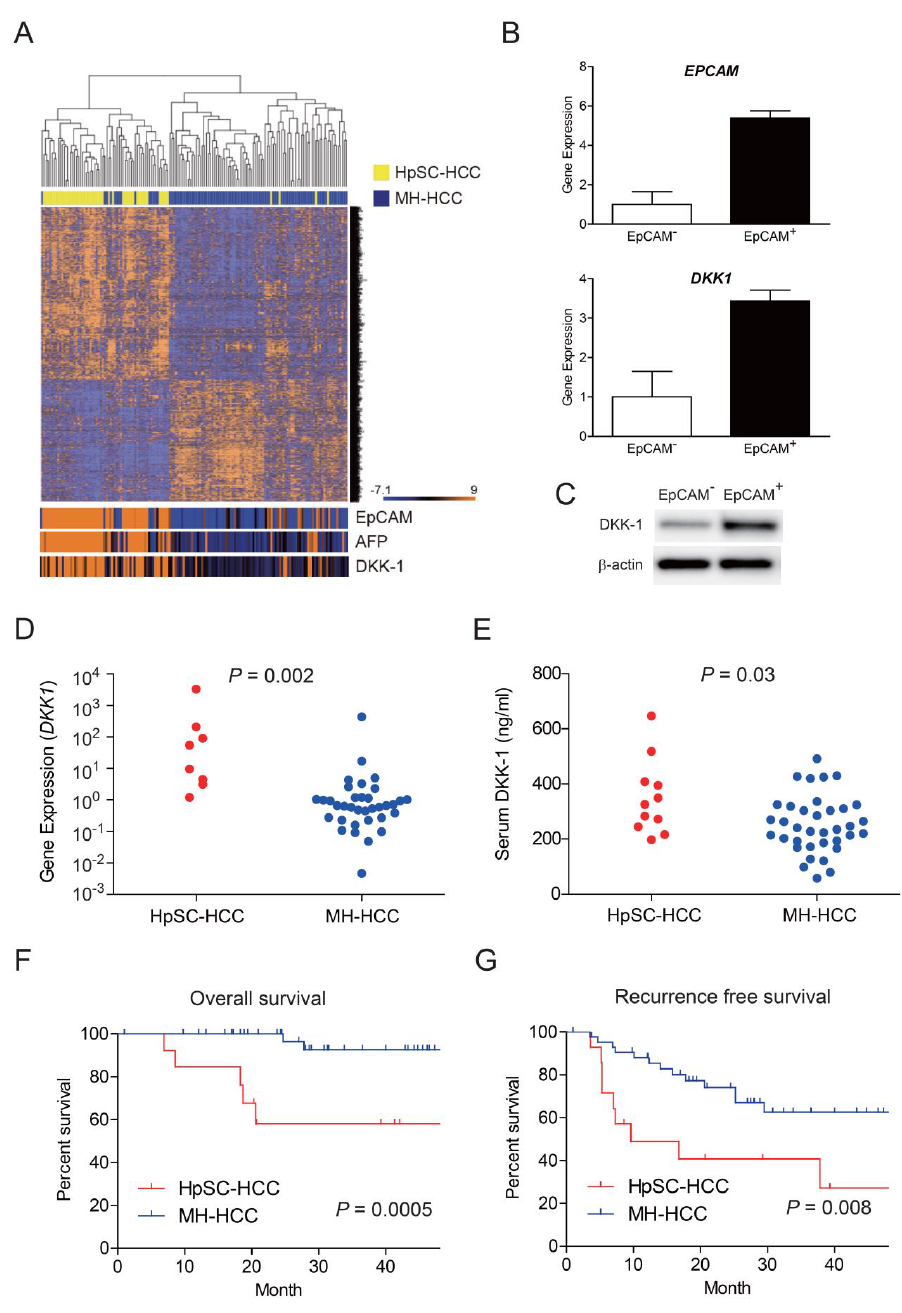
Figure 1. Activation of Dickkopf-1 (DKK-1) in hepatic stem cell-like hepatocellular carcinoma (HpSC-HCC). ( A ) Heatmap images of 793 genes differentially expressed between HpSC-HCC and mature hepatocyte- HCC (MH-HCC). HpSC-HCC and MH-HCC cases are indicated as yellow or blue boxes, respectively. Each cell in the matrix represents the expression level of a gene in an individual sample. Orange and blue cells depict high and low expression levels, respectively, as indicated by the scale bar. Genes encoding epithelial cell adhesion molecule (EpCAM), alpha-fetoprotein (AFP), and DKK-1 were activated in HpSC-HCC. ( B ) qRT-PCR analysis of genes encoding EpCAM and DKK-1 in sorted EpCAM +/ − Huh7 cells. ( C ) DKK-1 levels were higher in EpCAM + cells than in EpCAM − cells as assessed by Western blot analysis ( D ) qRT- PCR analysis of DKK-1 expression in HpSC-HCC (red circle) and MH-HCC (blue circle). ( E ) Serum DKK-1 levels in HpSC-HCC (red circle) and MH-HCC (blue circle). ( F ) Kaplan–Meier curves of overall survival in HpSC-HCC (red line) and MH-HCC (blue line). ( G ) Kaplan–Meier curves of recurrence-free survival in HpSC-HCC (red line) and MH-HCC (blue